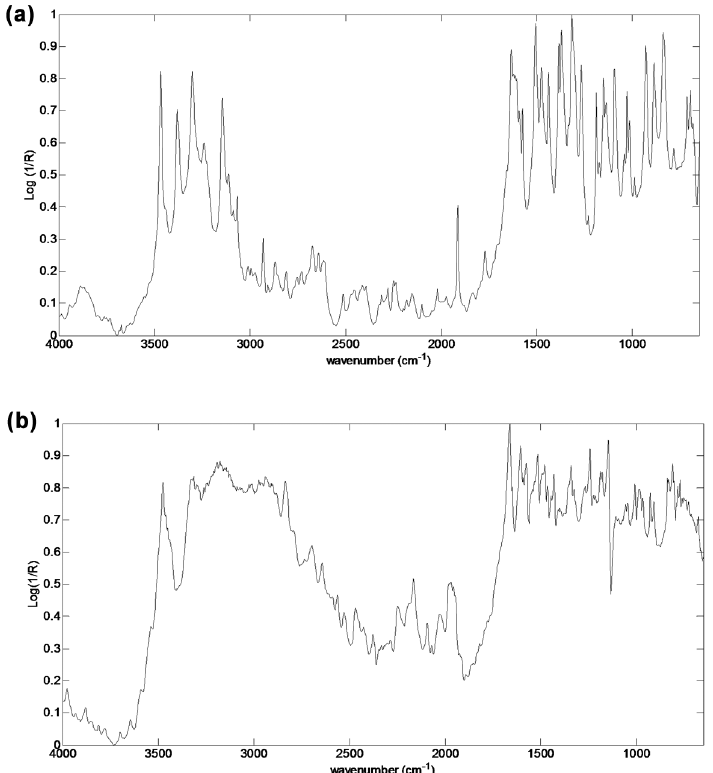
Figure 2 - DRIFTS spectra of sulphamethoxazole (A) and trimethoprim